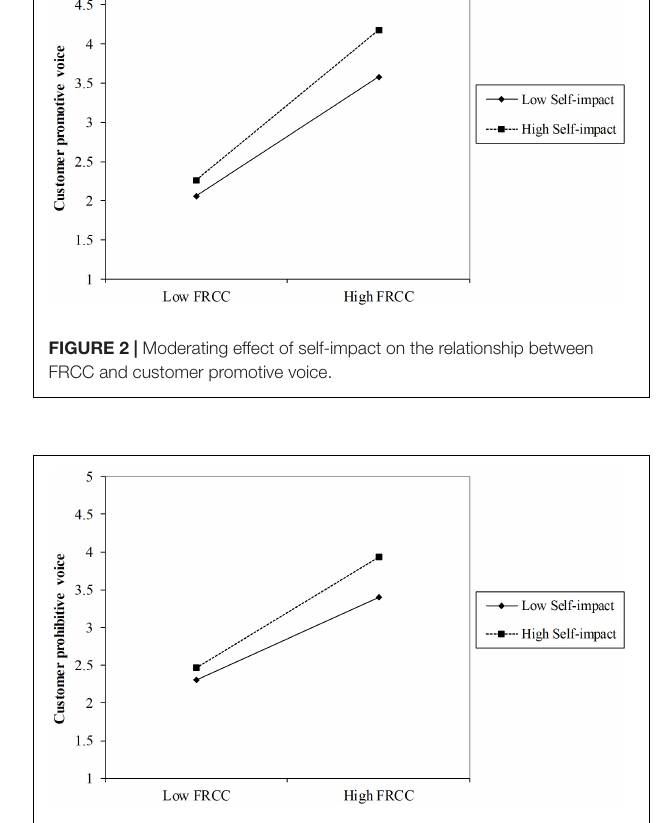
FIGURE 3 | Moderating effect of self-impact on the relationship between FRCC and customer prohibitive voice.